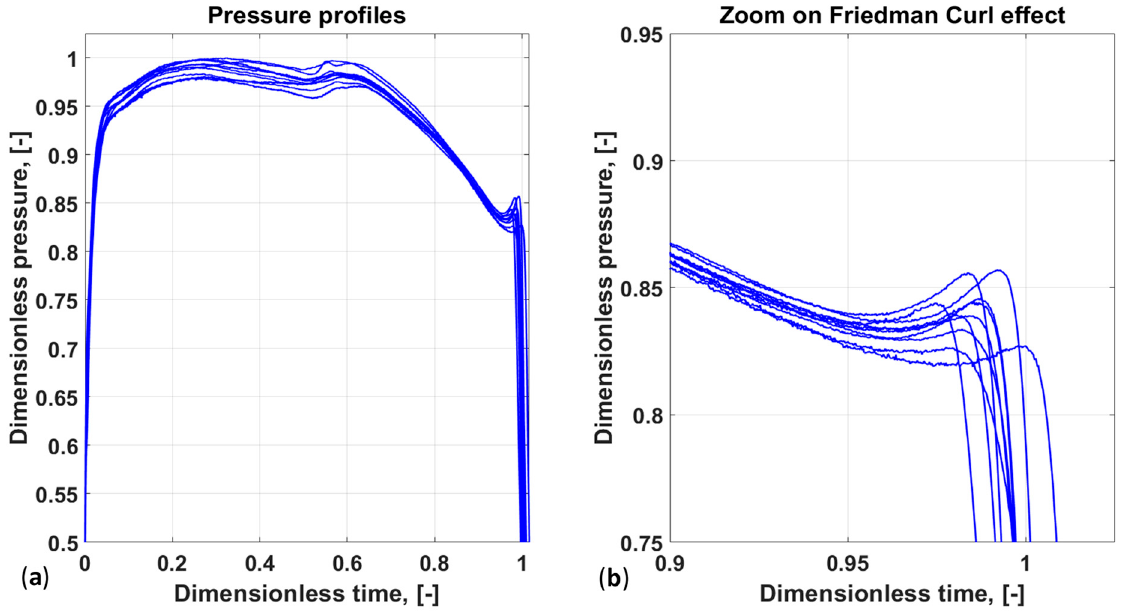
Figure 2. The Friedman Curl effect, taken from motor firings experimental data: ( a ) small-scale rocket motors showing Friedman Curl behavior; ( b ) Friedman Curl pressure peaks.